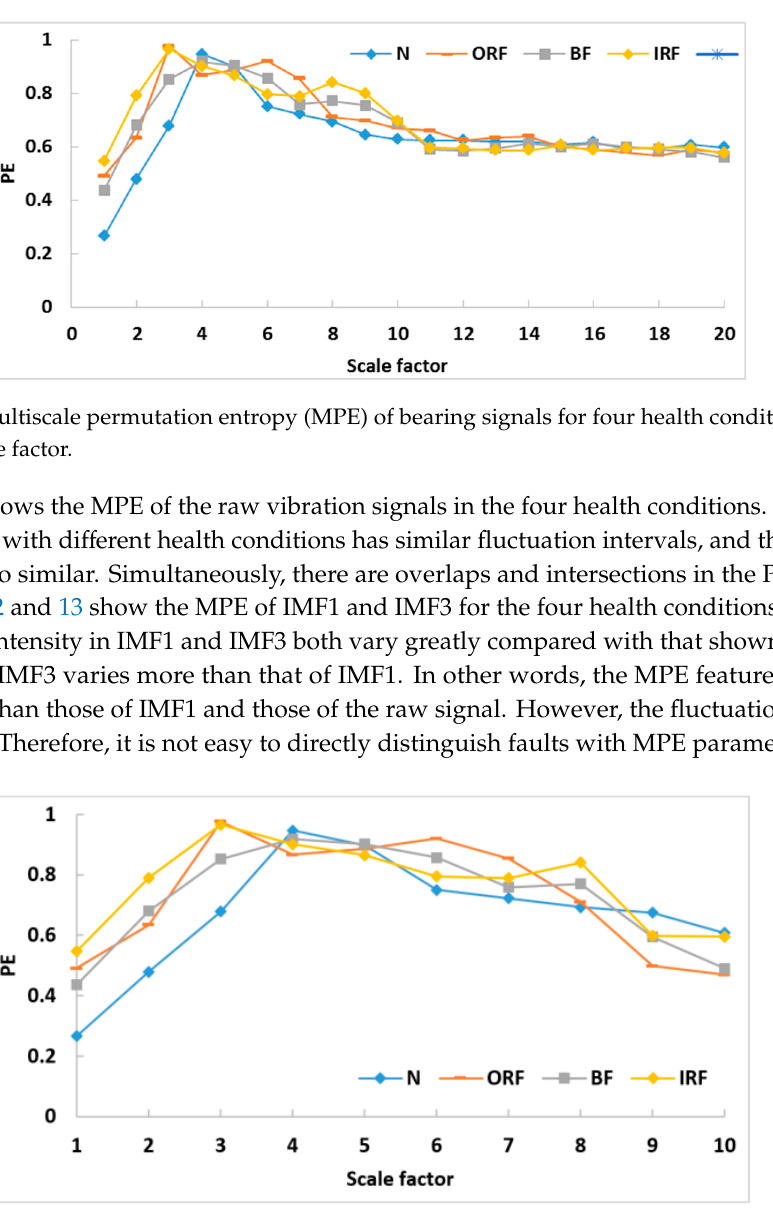
Figure 11. MPE of the raw vibration signals for four health conditions.